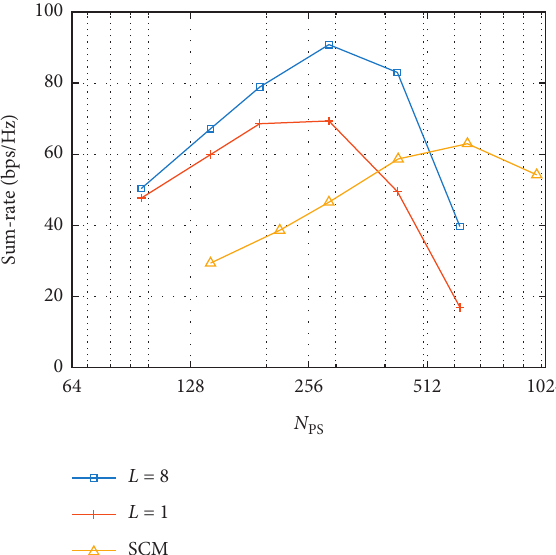
Figure 10: Sum-rate versus the number of phase shifters in dif- ferent channel environments ( v � 6 ,h � 6 ) .